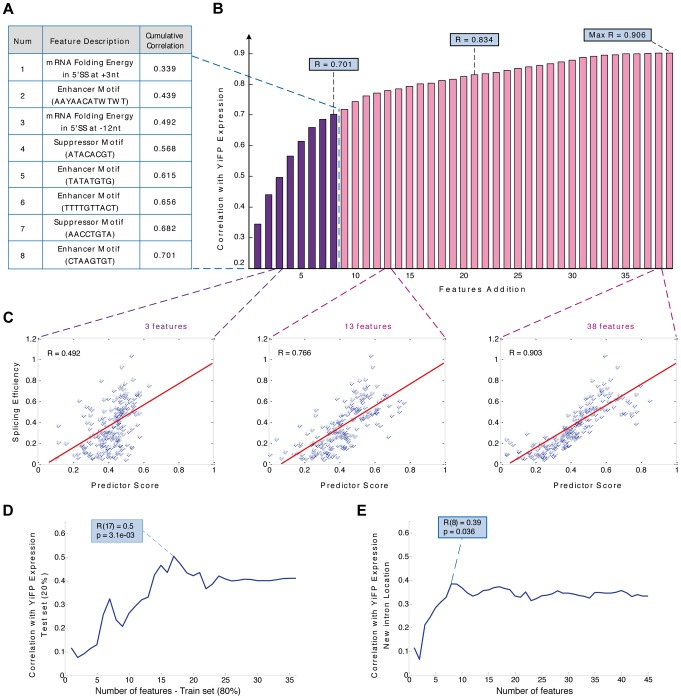
Modeling intron features uncovers design principles and allows the prediction of gene expression in a synthetic system.A) Sequence based predictor of gene expression assembly process: In every iteration the feature contributing the highest correlation to the reporter expression measurements was added. The first eight features and their description are presented. B) Bar diagram of the predictor's cumulative correlation with expression levels of YiFP variants as a function of the number of added features. C) A predictor function based on 3, 13, or 38 features was able to explain 49%, 77% and 90% of gene expression variation, respectively. (for 13 features: p<2.2e-16; empirical p<5e-03); D) Cross validation of the predictor assembly method using training and test sets, with 80% and 20% of introns respectively, demonstrated a predictive power of 50% (for >15 features: 0.37<r<0.5; p<3.6e-02). E) A new predictor assembled using strains with introns inserted to several locations in the YFP maintains 80% of the model's predictive power (r = 0.38; p = 0.036), suggesting that although some of the regulatory splicing information is not located in intronic regions, our methodology is able to predict intron regulation under several exon contexts.